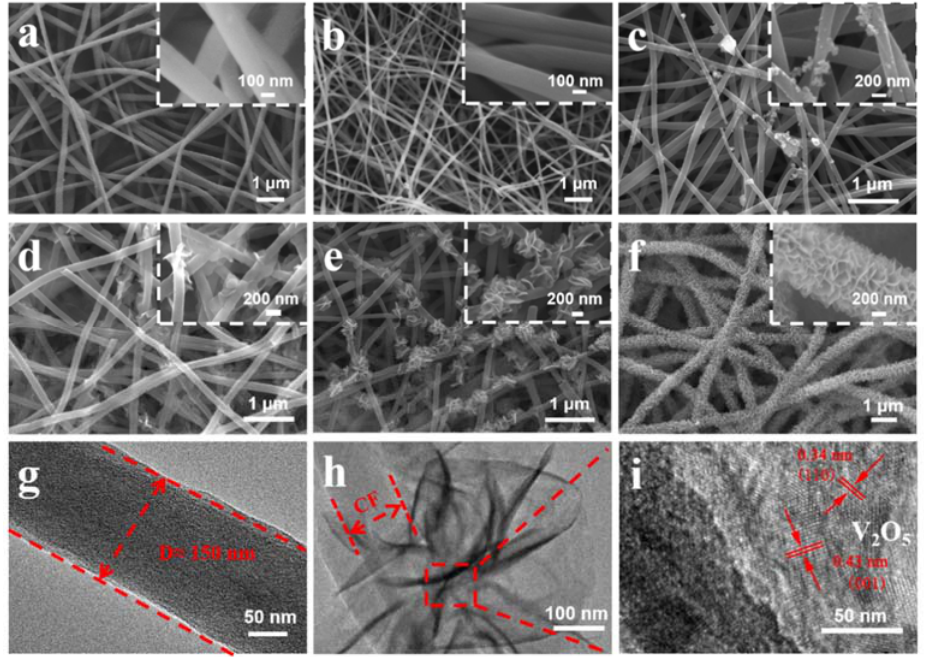
Figure 3. SEM images of the precursor polyacrylonitrile (PAN) fibers before ( a ) and after ( b ) carbonization. Figure ( c )–( f ) shows the SEM images for the CF membrane hydrothermally treated at 200 ◦ C for 1, 4, 8, and 12 h, respectively. (The inset of each figure shows the corresponding high magnification images). ( g ) shows the TEM image for CF sample, and ( h ) and ( i ) are the TEM and HRTEM images, respectively, for the V ‐ CF.